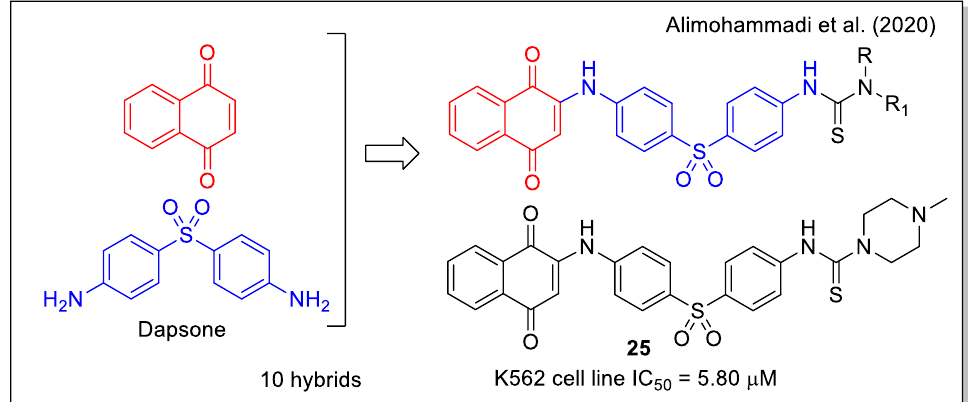
Figure 9. 1,4-Naphthoquinone-diaminodiphenyl sulfone hybrids as reported by Alimohammadi et al. [39].